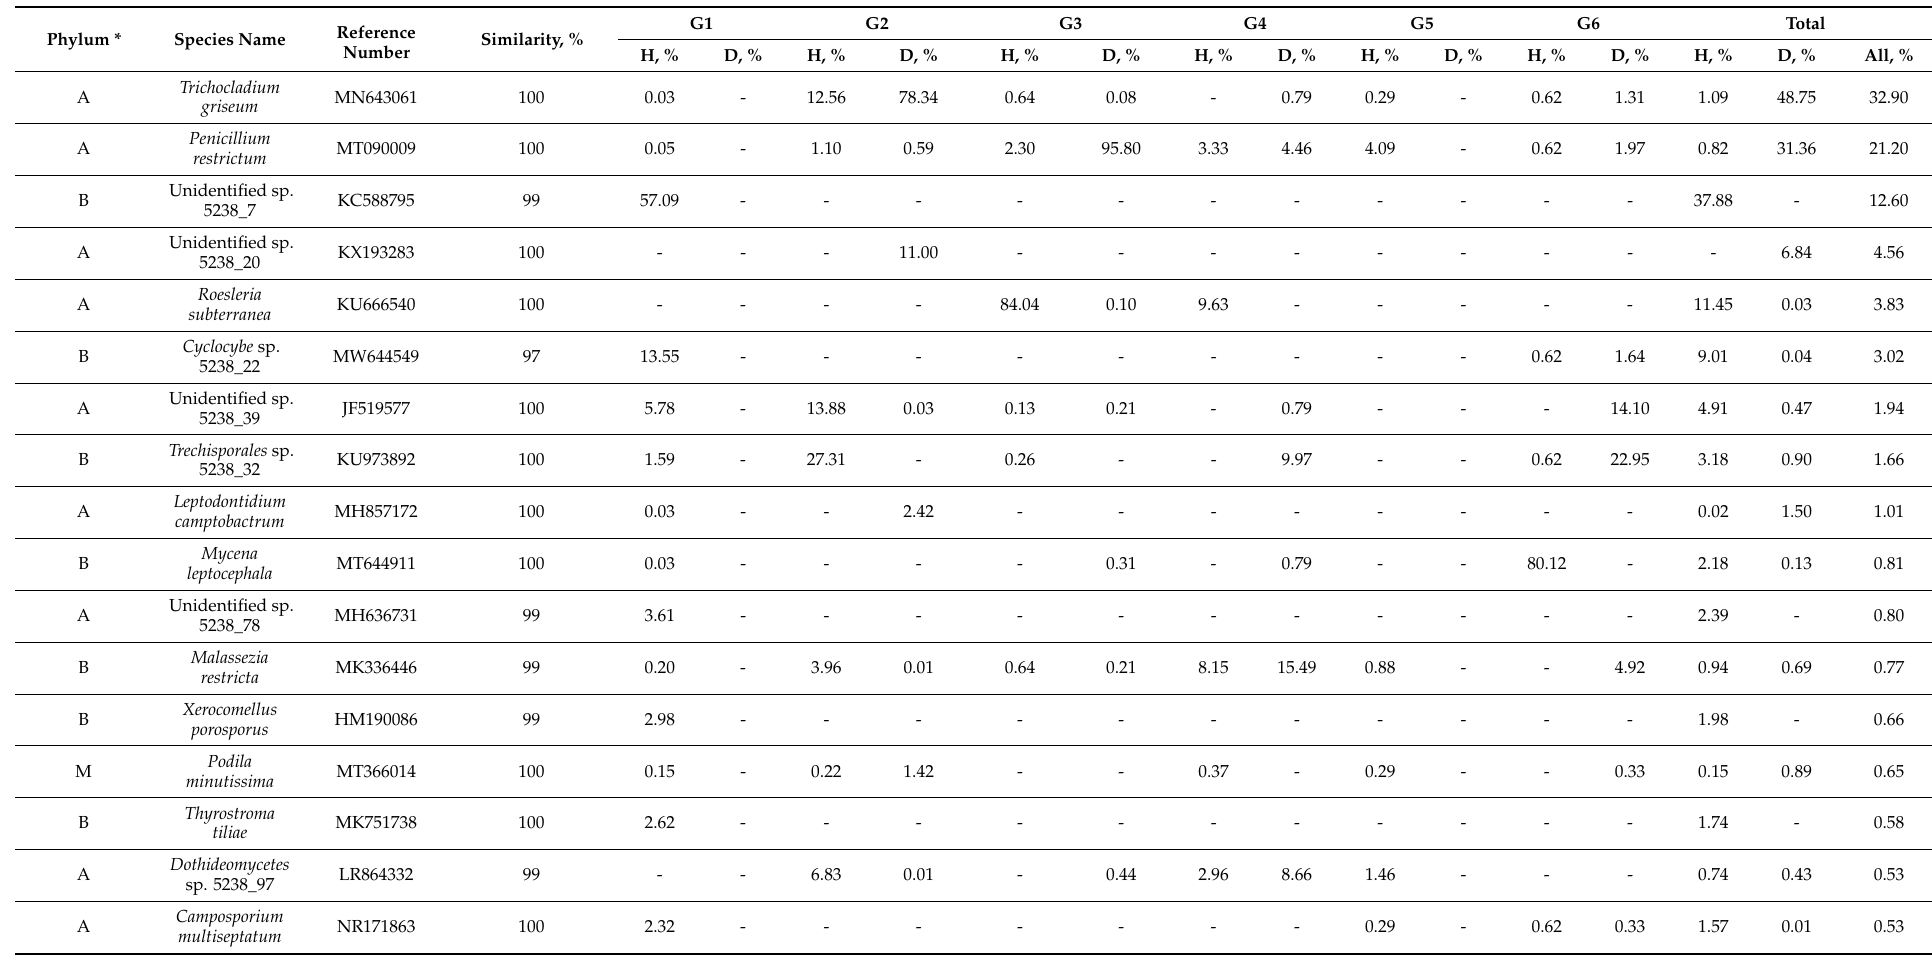
Table 3. Occurrence and relative abundance of the 30 most common fungal taxa (shown as a proportion of all high-quality fungal sequences) in roots of healthy-looking (H) and diseased (D) trees of Ulmus glabra sampled from different sites (G1–G6) in